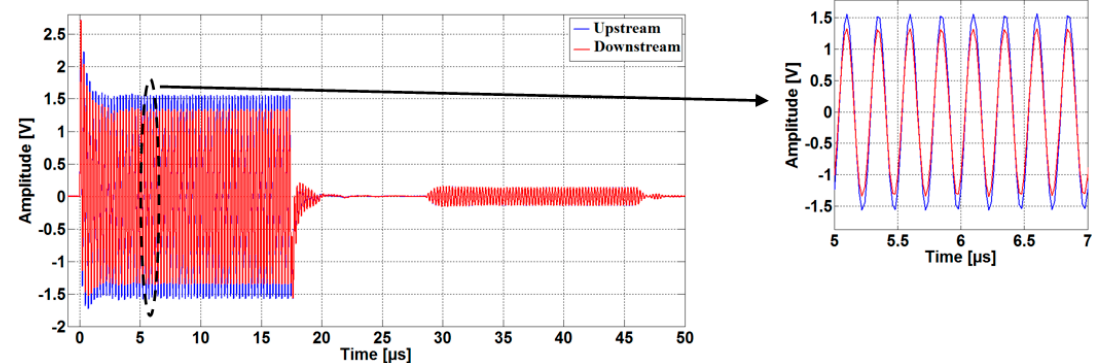
Figure 10. Acquired ultrasonic signals in the upstream and downstream directions (measured using a driving frequency of 4 MHz).